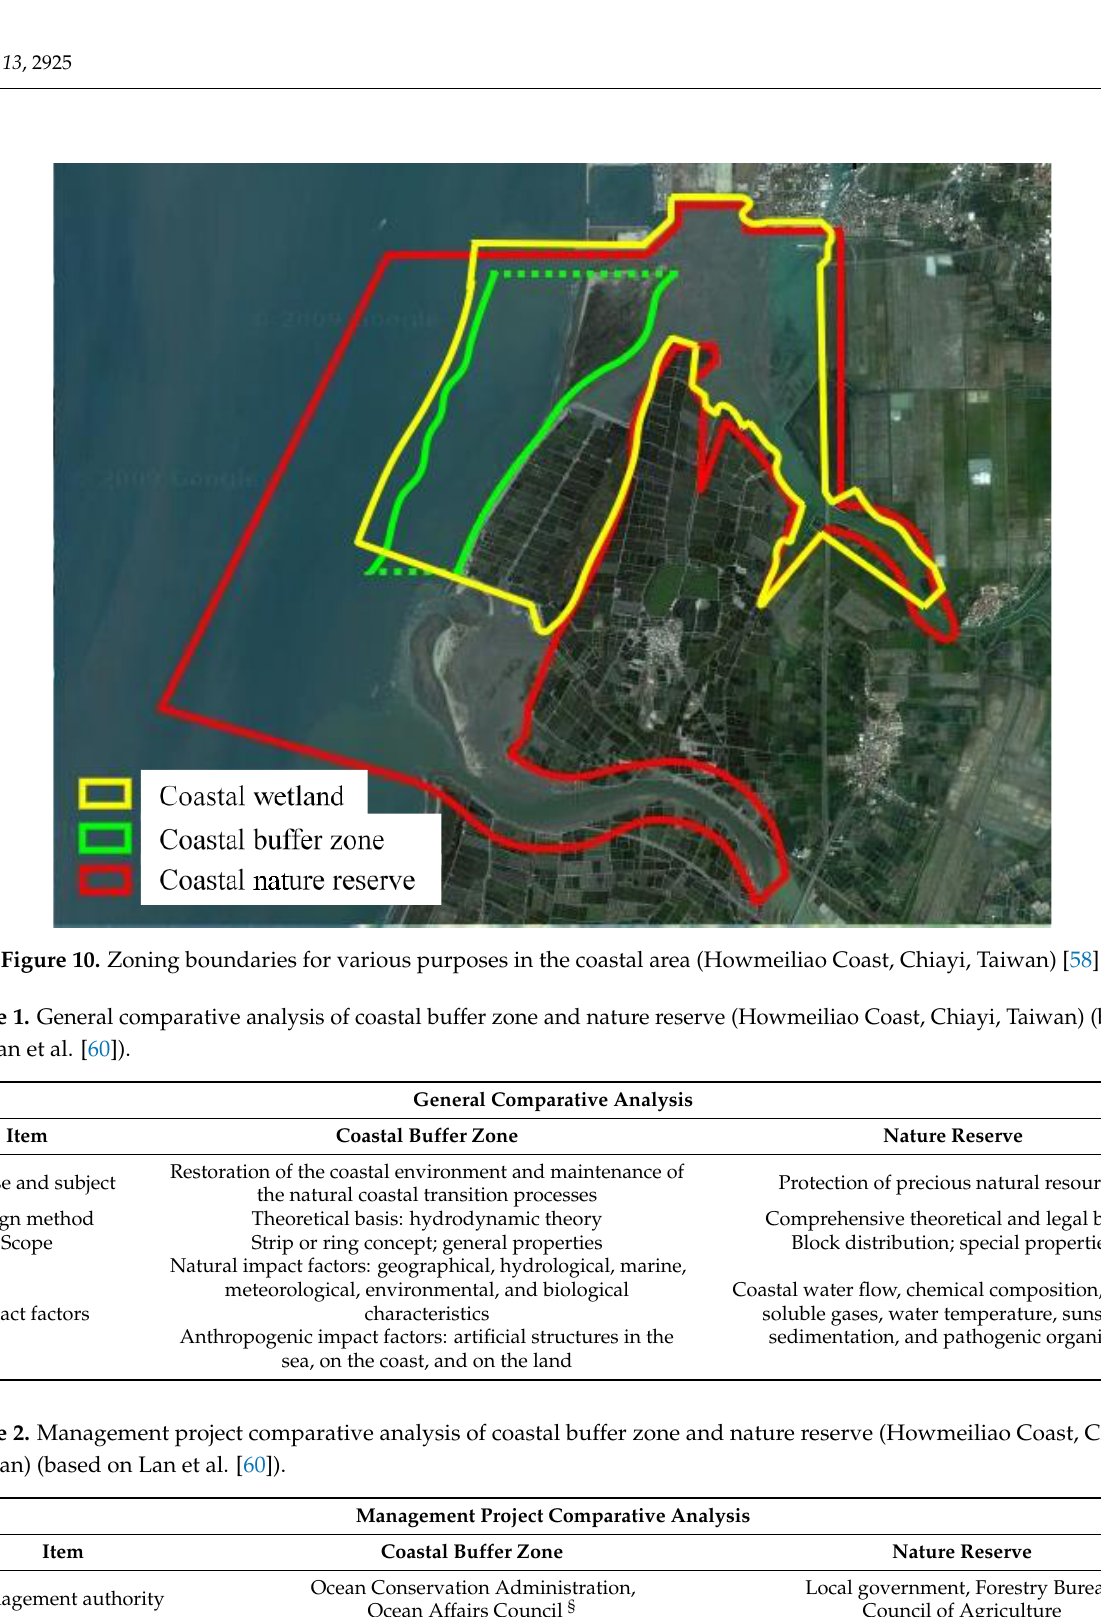
Table 2. Management project comparative analysis of coastal buffer zone and nature reserve